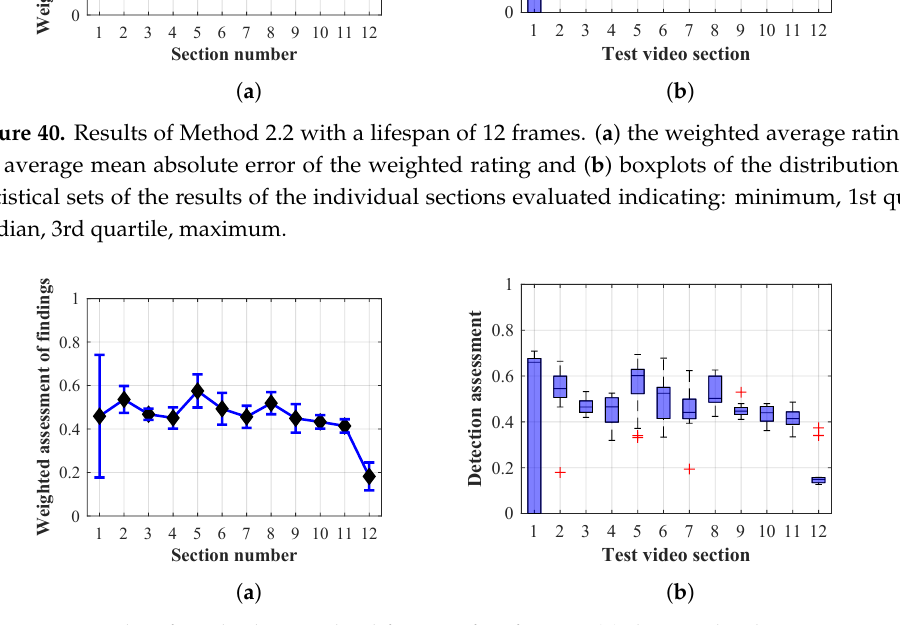
Figure 41. Results of Method 2.2 with a lifespan of 40 frames. ( a ) the weighted average rating with the average mean absolute error of the weighted rating and ( b ) boxplots of the distribution of the statistical sets of the results of the individual sections evaluated indicating: minimum, 1st quartile, median, 3rd quartile,